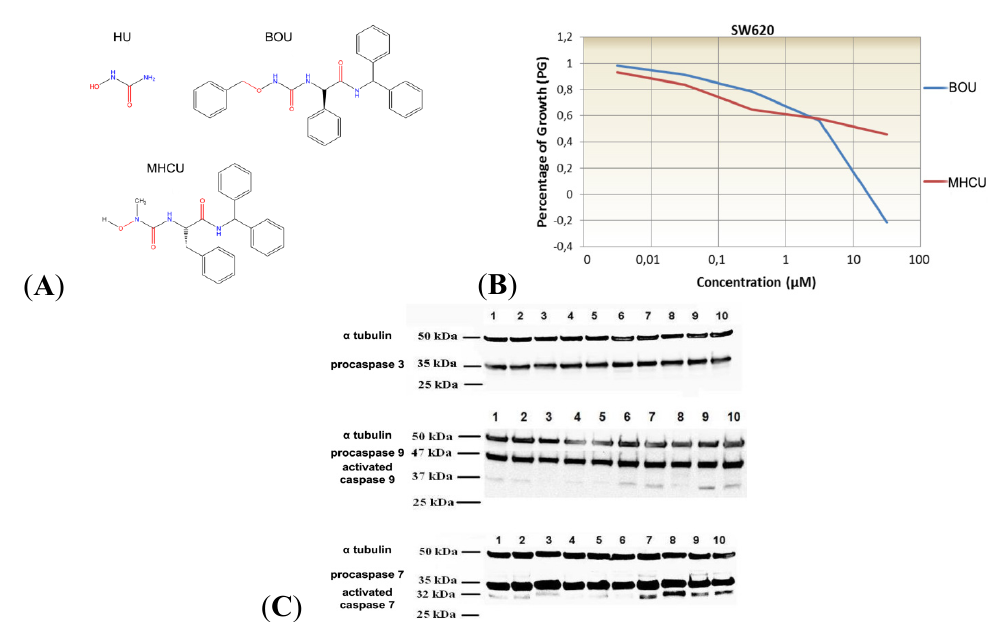
Figure 1. ( A ) Hydroxyurea (HU) and its derivatives N '-benzyloxycarbamoyl- D - phenylglycine benzhydrylamide ( BOU ) and N '-methyl- N '-hydroxycarbamoyl- L - phenylalanine benzhydrylamide ( MHCU ); ( B ) Concentration-dependent antiproliferative effect of BOU and MHCU on the SW620 cell line. Marginal means of survival were estimated as percentages of growth (PG); ( C ) Representative blots of SW620 cells treated with BOU and MHCU , probed with antibodies against human procaspase-3, procaspase-7 and procaspase-9. Treatments are as follows: 1 : control 24 h, 2 : BOU at 1 μM 24